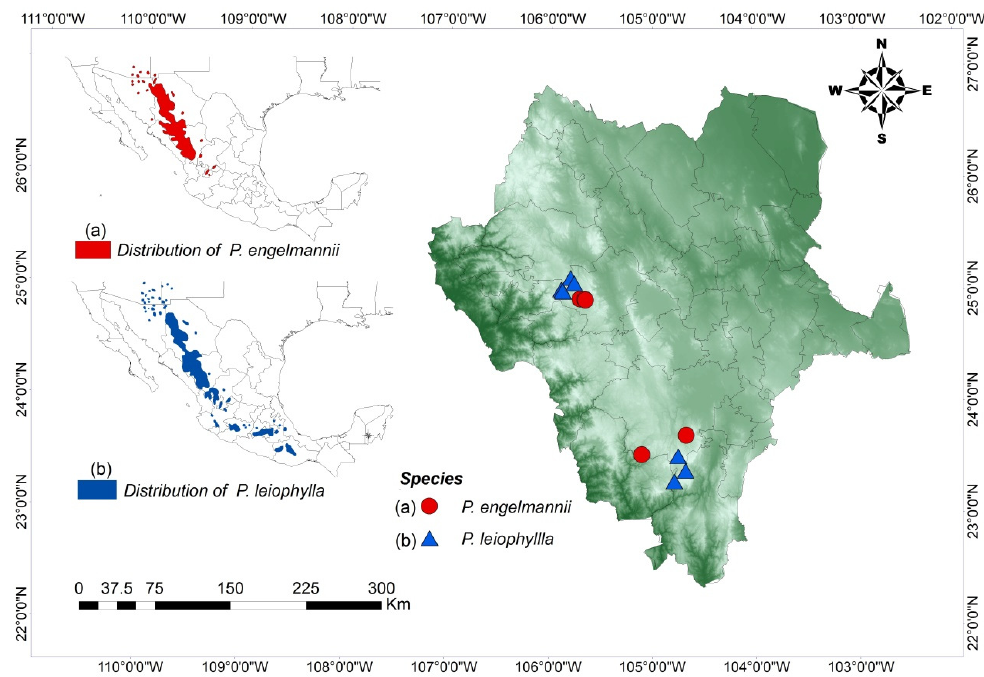
Figure 1. Locations of the Pinus engelmannii and P. leiophylla 16 seed stands in the Sierra Madre Occidental, Durango, Mexico. Maps showing the distribution areas of P. engelmannii and P. leiophylla ( a ) and the locations of the seven P. engelmannii and nine P. leiophylla seed stands under study in the Sierra Madre Occidental, Durango, Mexico ( b ). Seed stands: La Lisuda (PE ‐ Li), Mesa de Mingarreta (PE ‐ MM), Mesa de Perdederos 1 (PE ‐ MP), Mesa de Perdederos 2 (PE ‐ MP2), Mesa de Perdederos 3 (PE ‐ MP3), Mesa de Perdederos 4 (PE ‐ MP4), La Mesa de Veracruz (PE ‐ MV), Bajío (PL ‐ BE), Coloradas (PL ‐ C2), Cócono (PL ‐ CO), Maguey (PL ‐ M), Mesa de Cristo (PL ‐ MC), Patio (PL ‐ PA), Polvorín (PL ‐ PO), Rancho (PL ‐ RAN), and Tijera de Salsipuedes (PL ‐ TS).